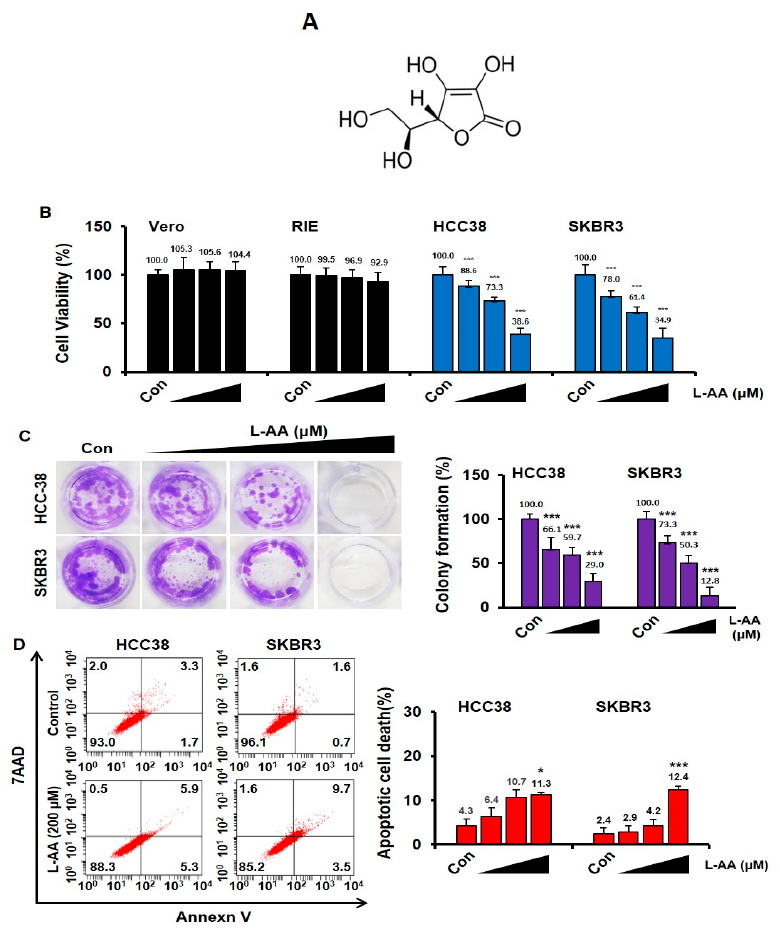
Figure 1. L-ascorbic acid (L-AA) inhibits breast cancer growth. ( A ) The chemical structure of L-AA. ( B ) Normal cells (Vero and rat intestinal epithelium (RIE)) and breast cancer cells (HCC38 and SKBR3) were treated with various concentrations of L-AA (50, 100, and 200 μ M) for 48 h and then stained with trypan blue. Viable and dead cells were counted. ( C ) Breast cancer cells were treated with L-AA (50, 100, and 200 μ M) every 3 days. After the 14 day treatment, cell colonies were stained with crystal violet. Crystal violet stained cells were extracted using 33% acetic acid and quantified by measuring absorbance at 570 nm on the microplate reader. ( D ) Breast cancer cells were treated with L-AA (50, 100, and 200 μ M) for 48 h and then stained with annexin V-FITC and 7AAD in the binding buffer at room temperature in the dark. Stained cells were detected by LSRFortessa flow cytometry. The graph shows the sum of annexin V-FITC alone-positive cells (early apoptotic cells) and annexin V-FITC and 7AAD double positive cells (late apoptotic cells) from whole stained cells. Data are shown as the mean of three independent experiments, and the error bars represent standard deviation (SD). * p < 0.05 and *** p < 0.001 versus the control group.